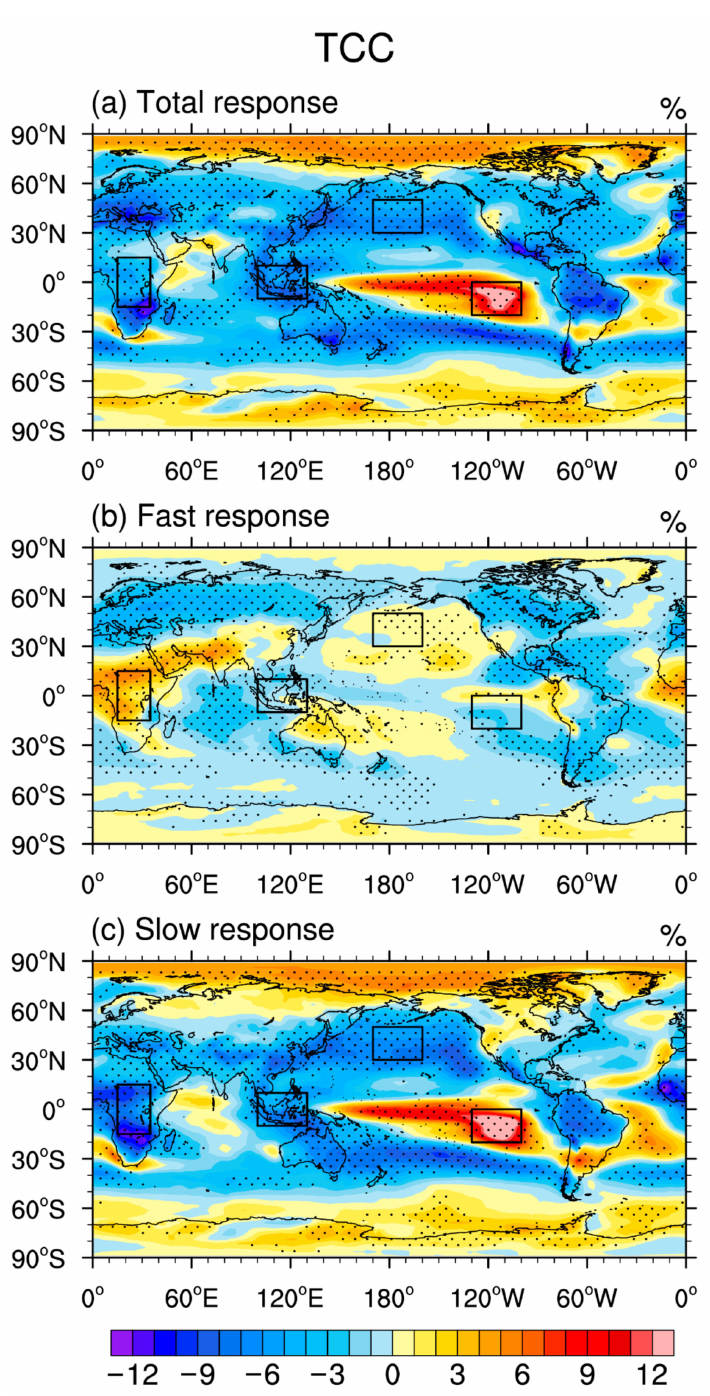
Figure 2. ( a ) Total, ( b ) fast, and ( c ) slow responses of global total cloud cover (units: %). Black dot represents that at least 8 models agree with the sign of